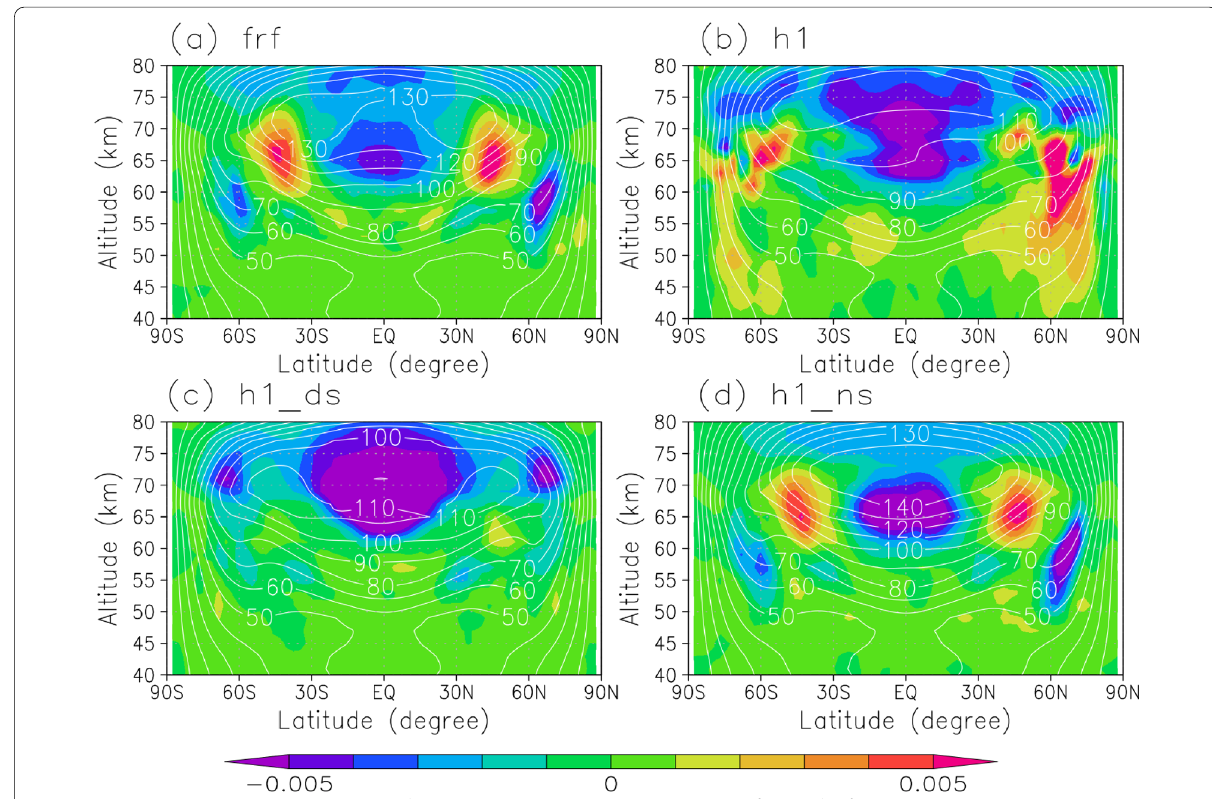
Fig. 5 Zonal–mean zonal wind (contours, m s − 1 ) and vertical momentum flux (colours, 10 − 3 kg m − 1 s − 2 ) in a latitude–height cross section averaged over the last 30 Earth days. The cases of a frf, b h1, c h1_ds, and d h1_ns are